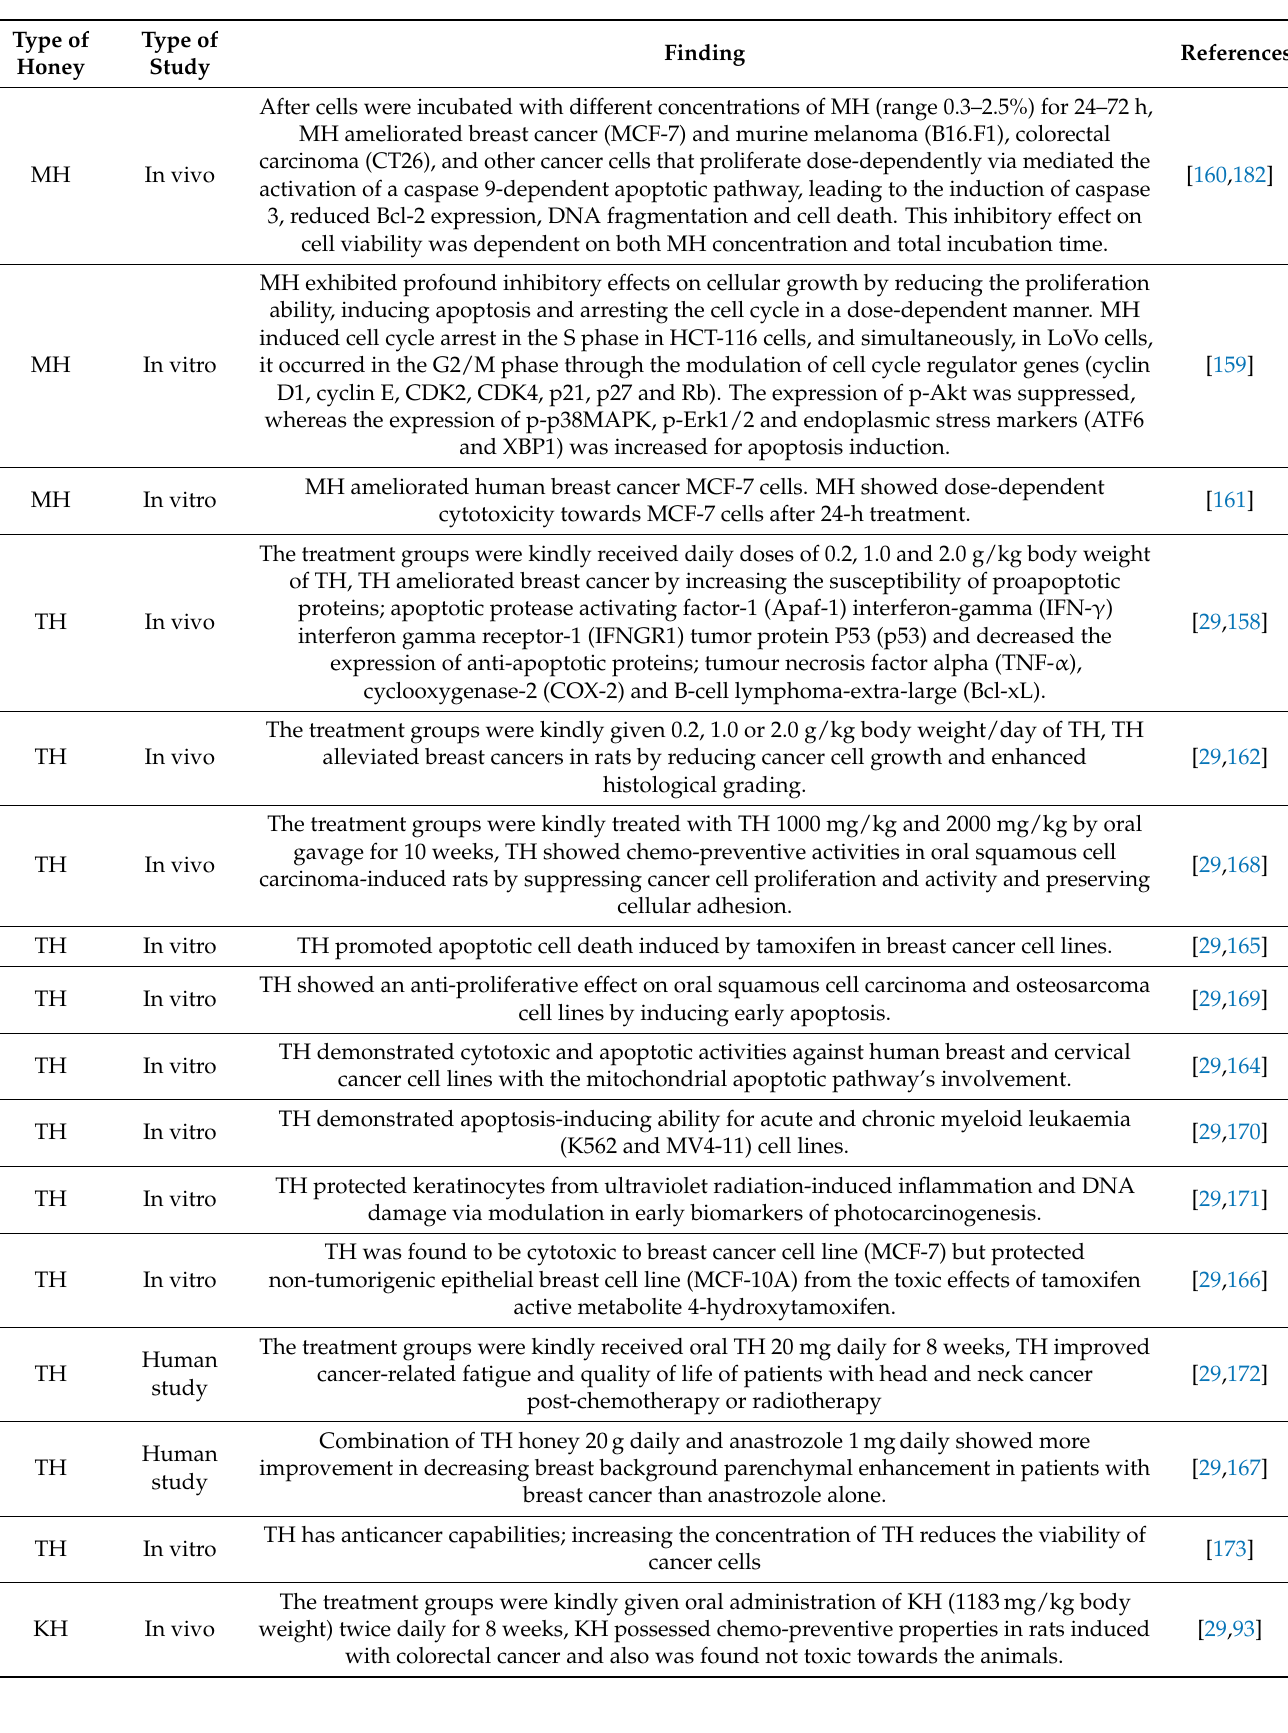
Table 5. List of anticancer properties of MH, TH, KH, and